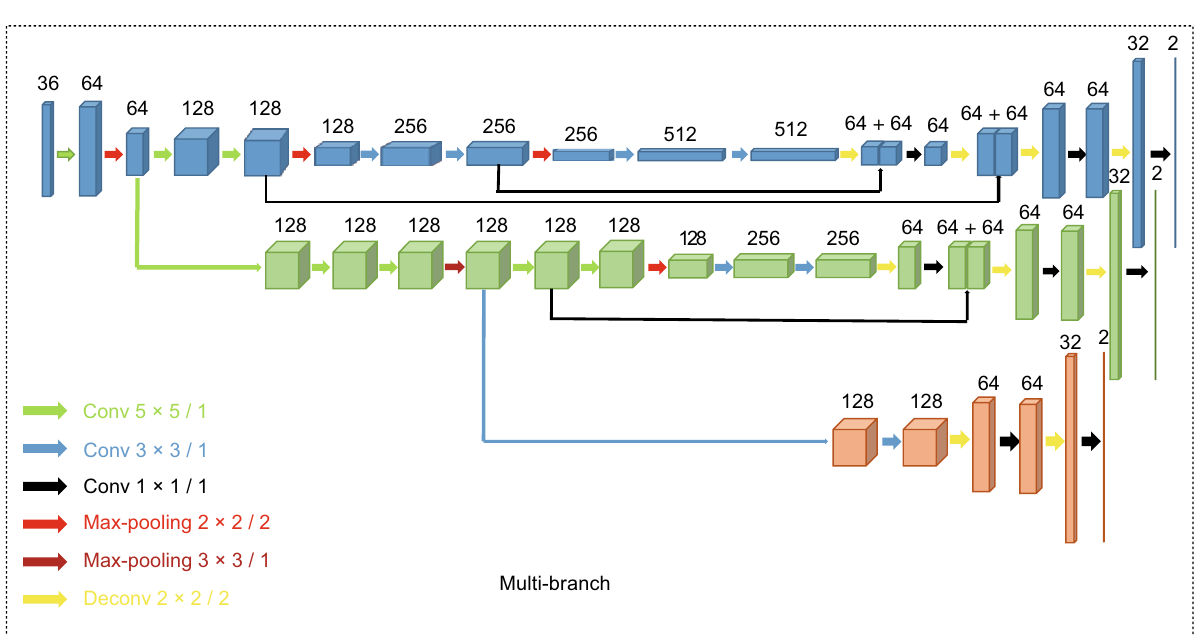
Figure 1. Architecture of MFCN . The MFCN includes three modules: a multi-scale inception module, a multi-branch sampling module and a multi-scale ensemble module. The multi-scale module uses three different kernel size convolutional layers (3 × 3, 5 × 5, 7 × 7, stride 2) to extract features, which are expanded to form branches concatenated with other modules, respectively. In multi- branch module, we have combined three branches (blue, green and light red) with different steps of down-sampling and up-sampling (blue: 16× down-sampling and up-sampling; green: 8× down-sampling and up-sampling; light red: 4× down-sampling and up- sampling). Finally, the ensemble module combines multi-mode features extracted from the multi-branch module to detect vesicles with different sizes and shapes. The number of channels of feature maps is denoted on top of the cuboids and the arrows denote the different operations (kernel